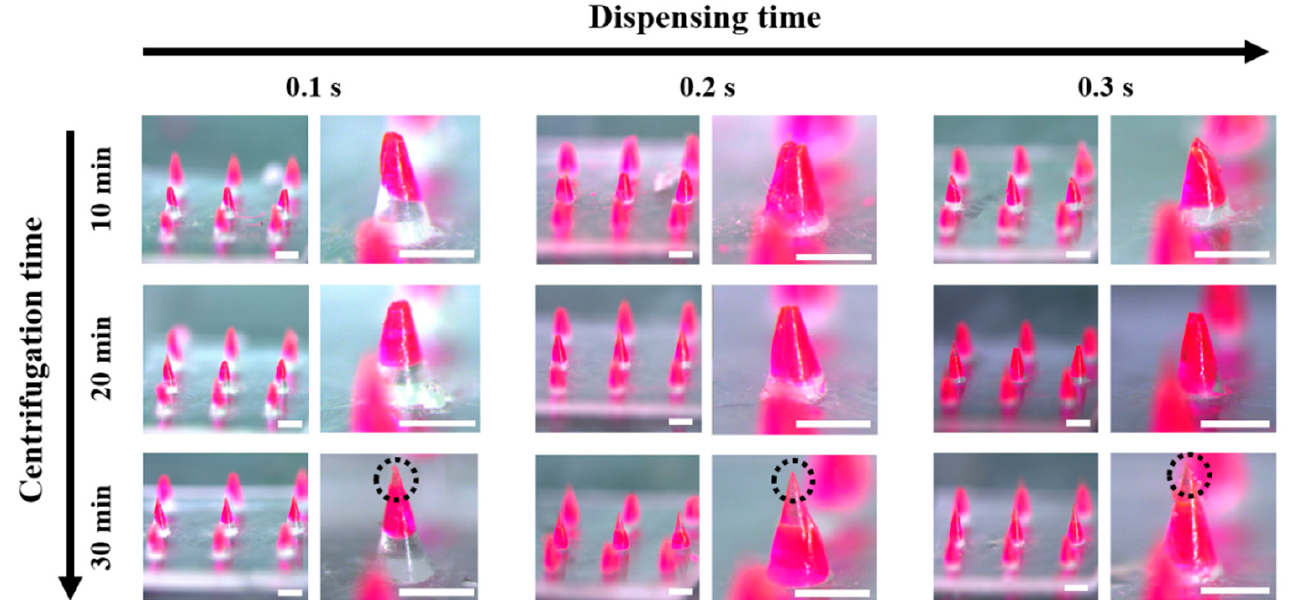
Figure 3. Images of HMP-DMN arrays at each fabrication condition. Sharpness increased depending on centrifugation time, in the order of 10, 20, and 30 min. In addition, the volume of the PLGA mixture increased as the dispensing time increased, at the same centrifugation time. The HMP-DMNs displayed the sharpest tips after 30 min of centrifugation time, when the volume of the PLGA mixture loaded with the model drug was controlled by tuning the dispensing time. Scale bar: 500 µ m. (HMP-DMN: heat-melt PLGA dissolving microneedle, PLGA: poly(lactic-co-glycolic acid)).